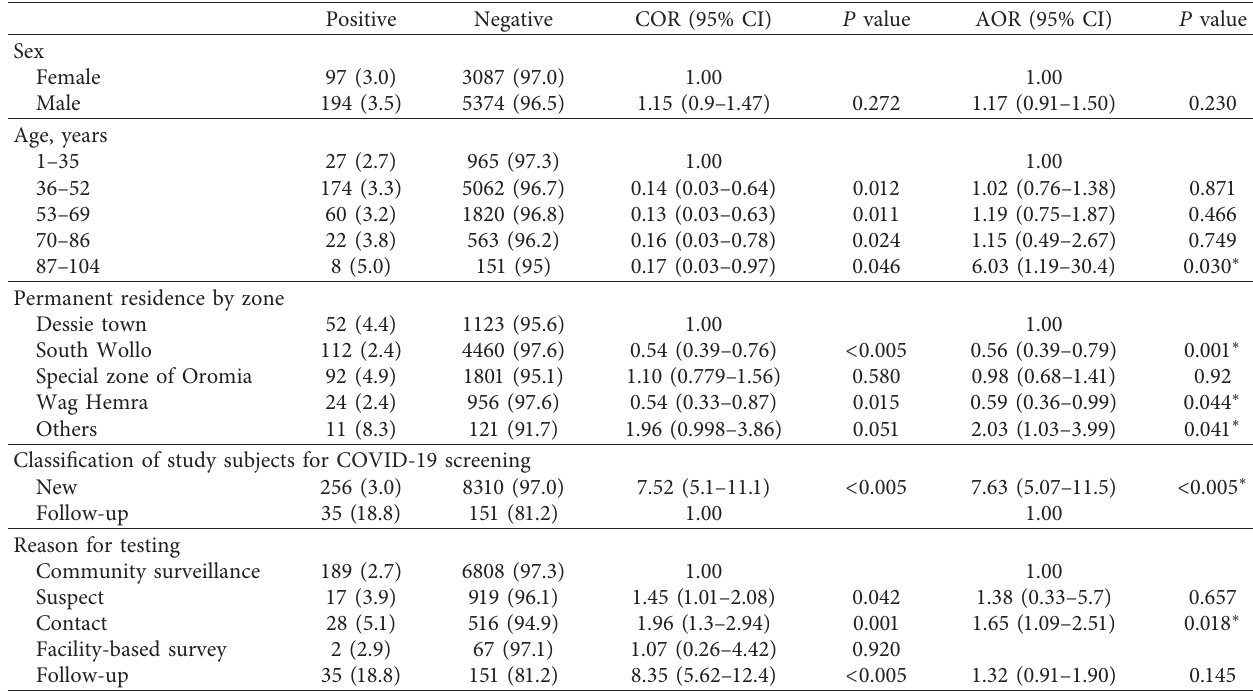
Table 4: COVID-19 infections and associated factors among study participants in the northeastern region of Ethiopia,